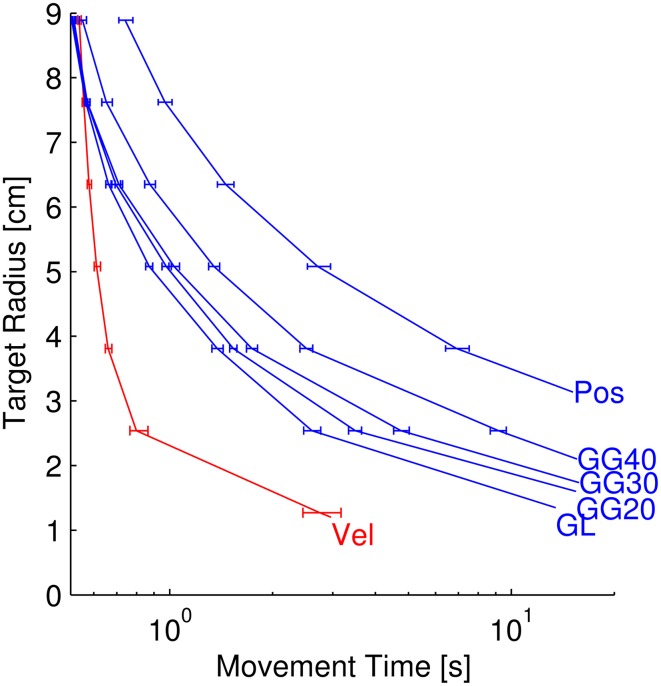
Target radius vs. movement time for separate neuron types. Each curve represents the relationship between target radius and movement time for simulated reaches using 50 position, velocity, or goal neurons of the respective types (GL, linear goal; GG, Gaussian Goal of 20, 30, or 40 cm standard deviation). The bottom-right-most points of each series represent the minimum achievable target radius (MATR-TP) from Figure 6. The error bars represent the 95% confidence interval of the movement times at particular target radii.